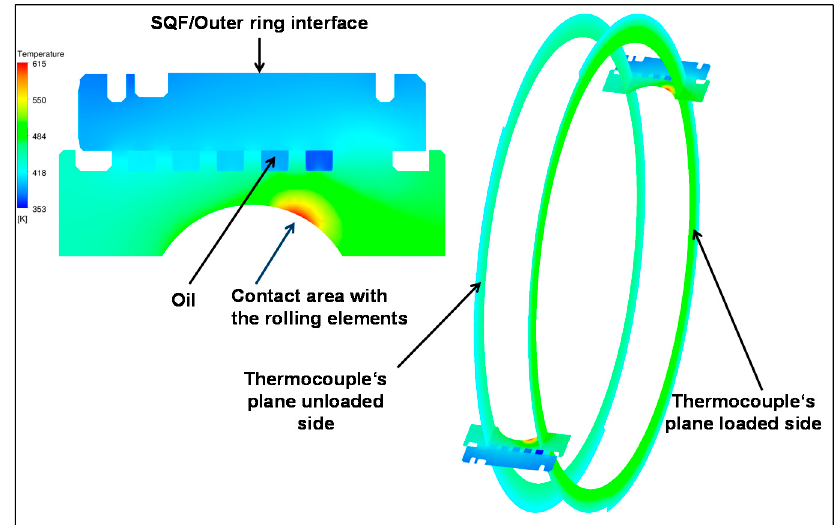
19 of 26 Table 4. Comparison between the measured and the calculated average temperatures for the Outer ring at the operating conditions mentioned above. Measured Material and Oil Temperatures Loaded/Unloaded Side (°C) Calculated Material and Oil Temperatures loaded/unloaded side (°C) Material: 201/175 Material: 202/174 Oil: 141 (exit) Oil: 140 (exit) For the hydraulic assessment a series of computations took place with flows ranging between 3 and 415 L/h. The pressure drop in the outer ring duct was evaluated and results were compared to results derived by the correlation, Δ p = 0.5 (cid:2025) (cid:1873) (cid:2870) (cid:3013) (cid:3031) (cid:3166)(cid:3161)(cid:3173)(cid:3176) (cid:1858) , with the friction loss coefficient f from Equation (17).